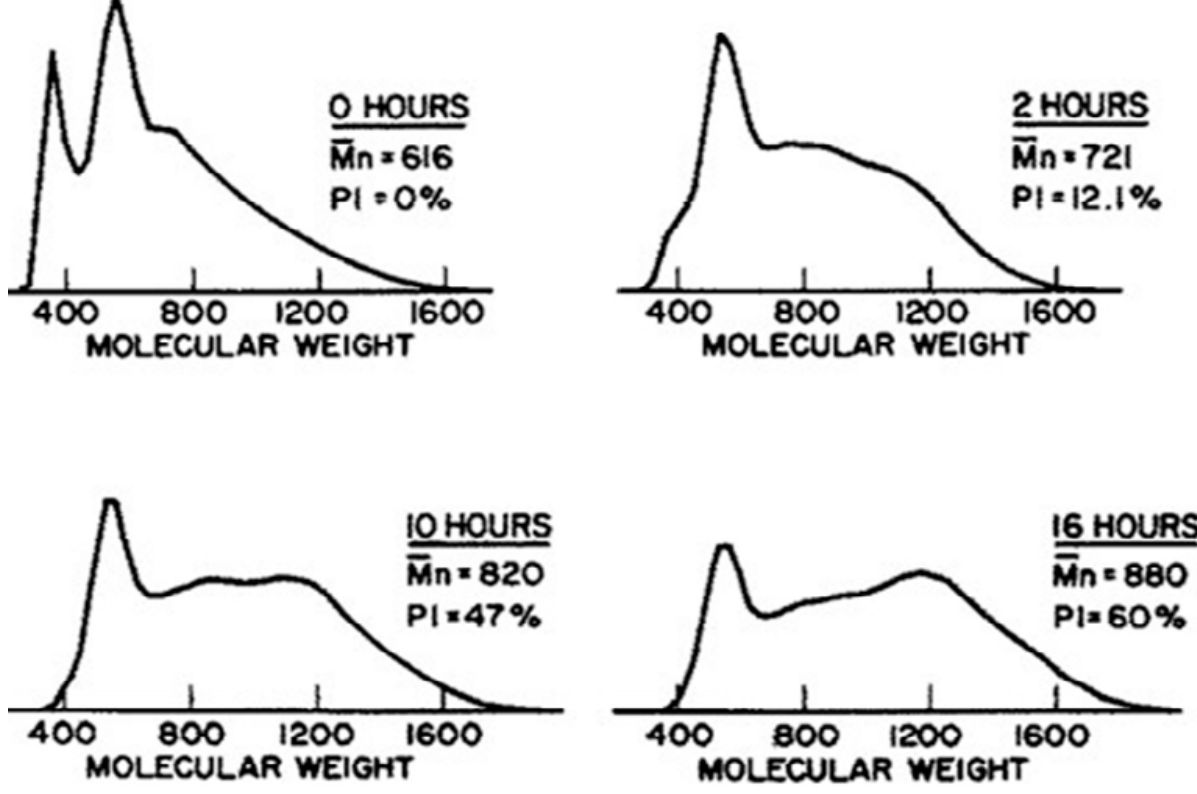
Figure 2. Molecular weight distribution of pitch during volatilization and mesophase formation steps; permitted from ref. [47].